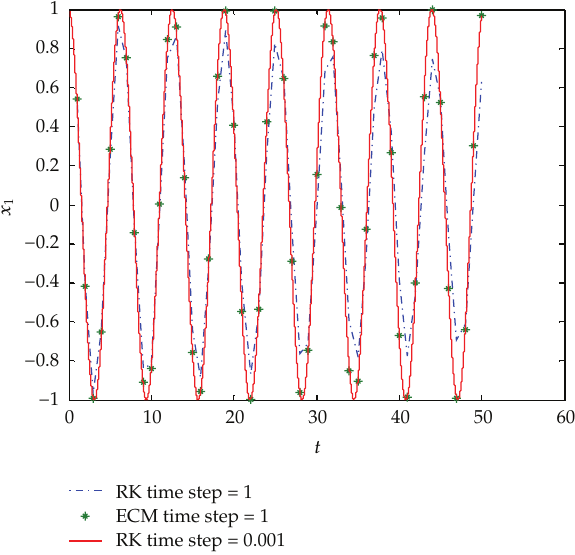
Figure 5: Comparison of